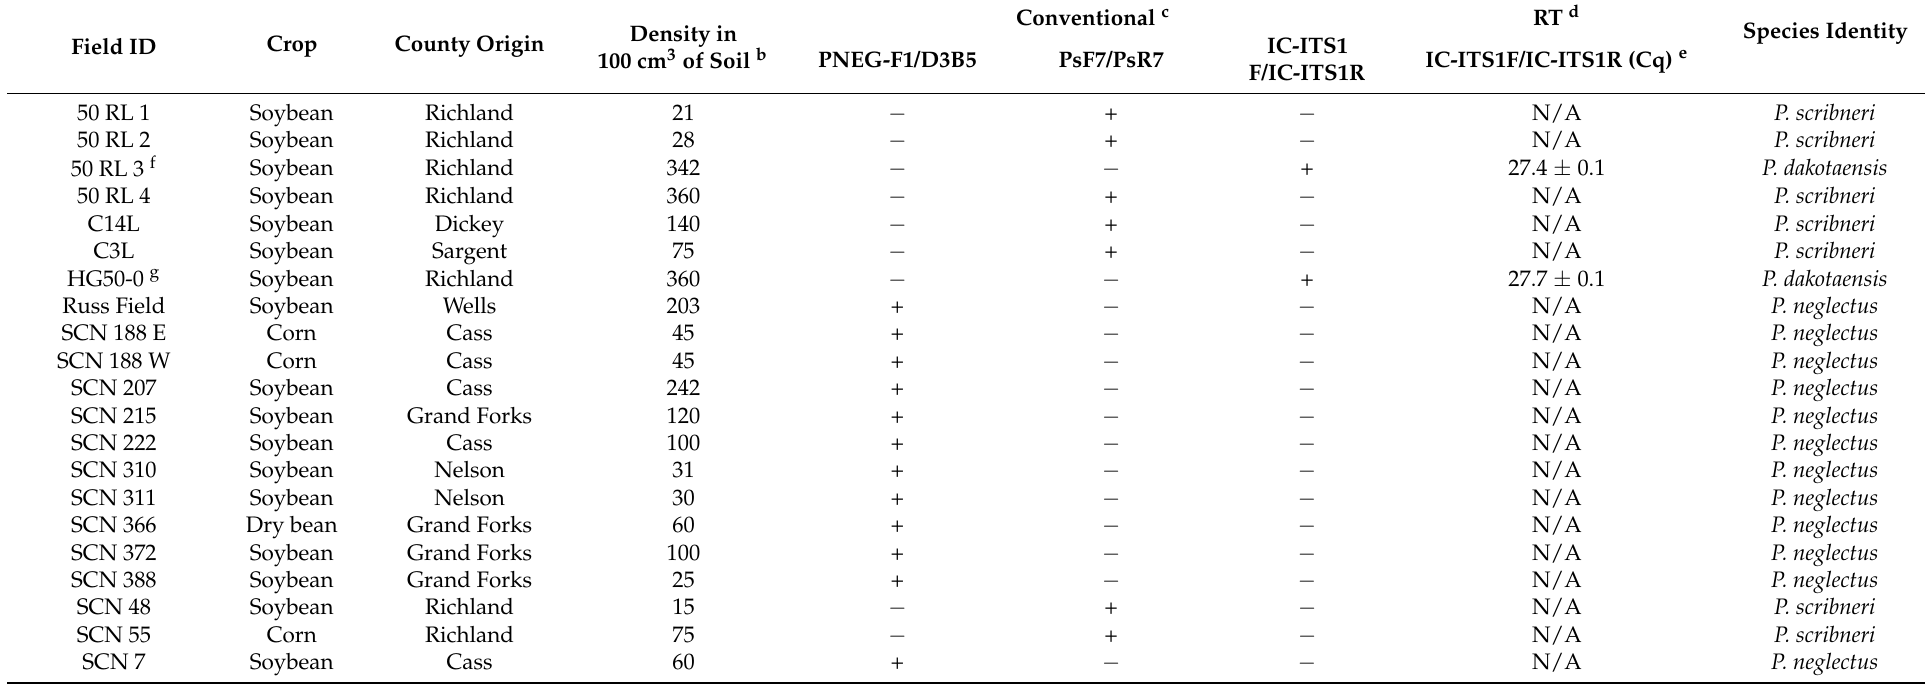
Table 3. Identification of Pratylenchus spp. collected from 20 soybean fields in North Dakota by species-specific polymerase chain reaction (PCR) assays a .